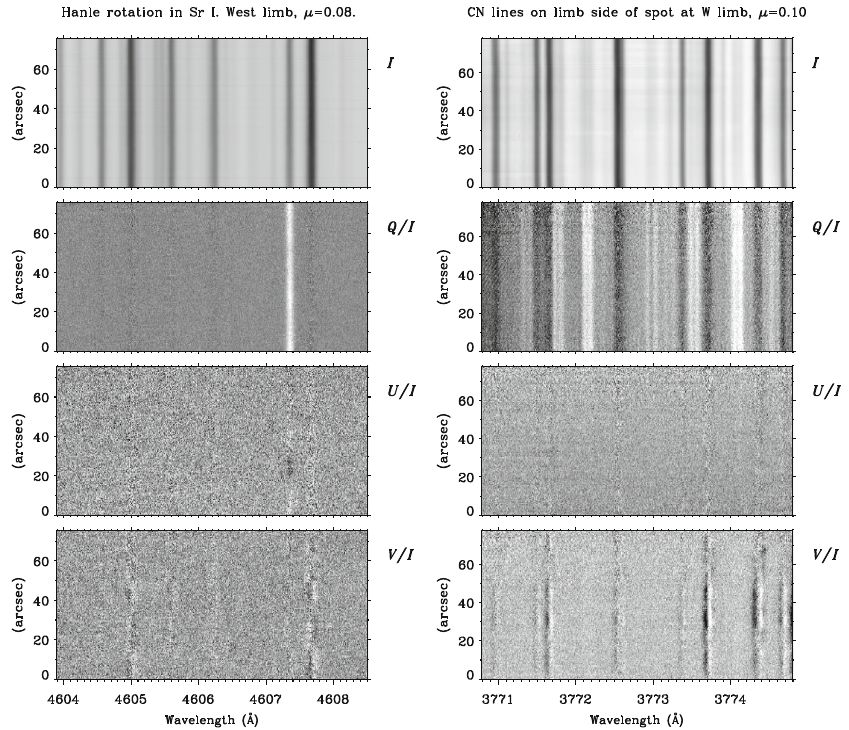
Fig.33 ZIMPOL observations of scattering polarization in photospheric lines. Left: Sr i 460.7 nm measure- ments taken at THEMIS on 7 August 2007. The spectrograph slit scanned a quiet region near the W limb ( µ = 0 . 08). The Sr i line exhibits a prominent Q signal. Except for a clear patch at y ∼ 25 (cid:2)(cid:2) , Stokes U is zero. The atomic line to the right shows very weak Stokes V signals all along the slit. Image courtesy J.O. Stenflo. Right: Molecular CN lines around 377.3 nm. The measurements were taken at the McMath–Pierce Telescope on 28 March 2005 with the slit parallel to the limb ( µ = 0 . 1). The CN lines are unconspicuous in Stokes I , but produce clear Q signals (the white vertical bands). Image reproduced with permission from Stenflo (2007), copyright by